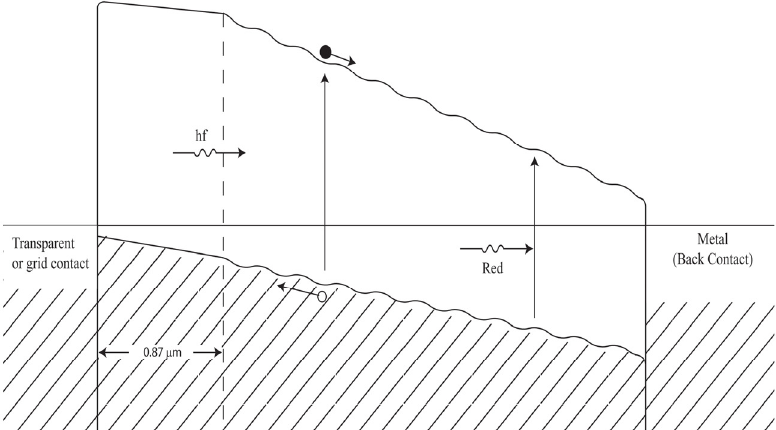
Figure 12. Shape of the energy band diagram of the improved devices with lower Si doping at the back of the solar